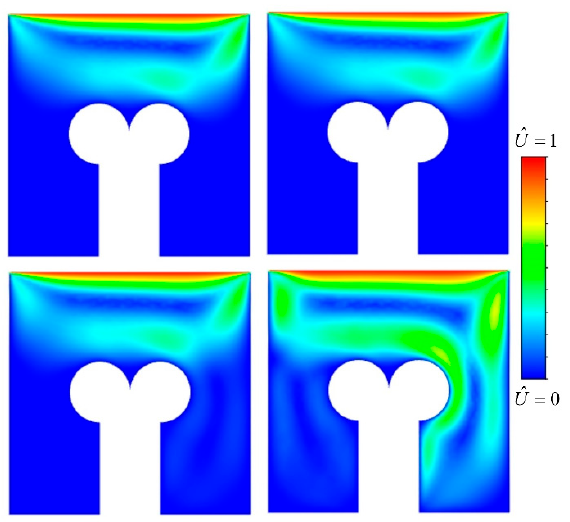
Figure 8. Velocity contours for the C2 fin with Re = 100 for varying Rayleigh numbers. From left to right, top to bottom: Ra = 10 3 , Ra = 10 4 , Ra = 10 5 , and Ra = 10 6 .